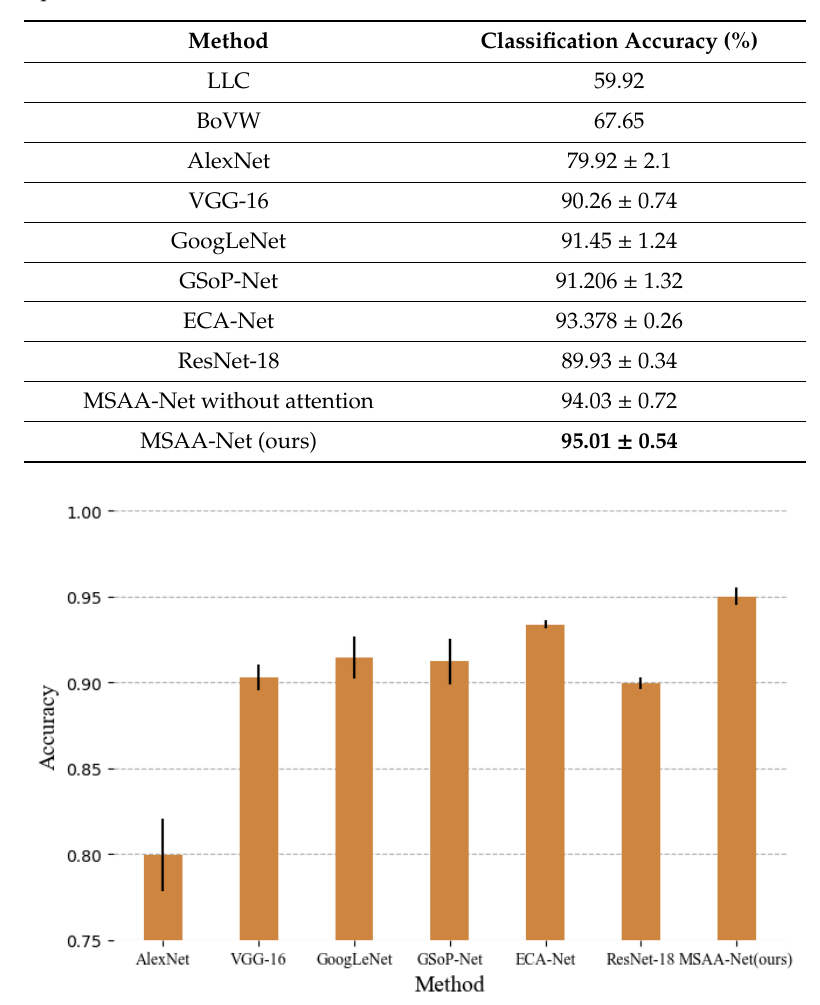
Figure 12. Classification results of different methods for NWPU-RESISC45 dataset. Table 2. Comparison between the previous reported accuracies with NWPU-RESISC45 dataset, with 50% training samples selected.